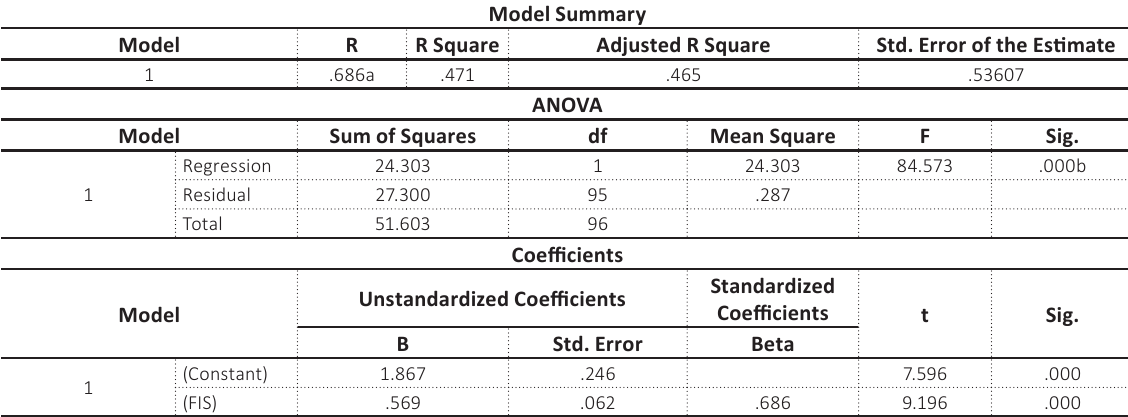
Table 7. Testing the 3rd hypothesis